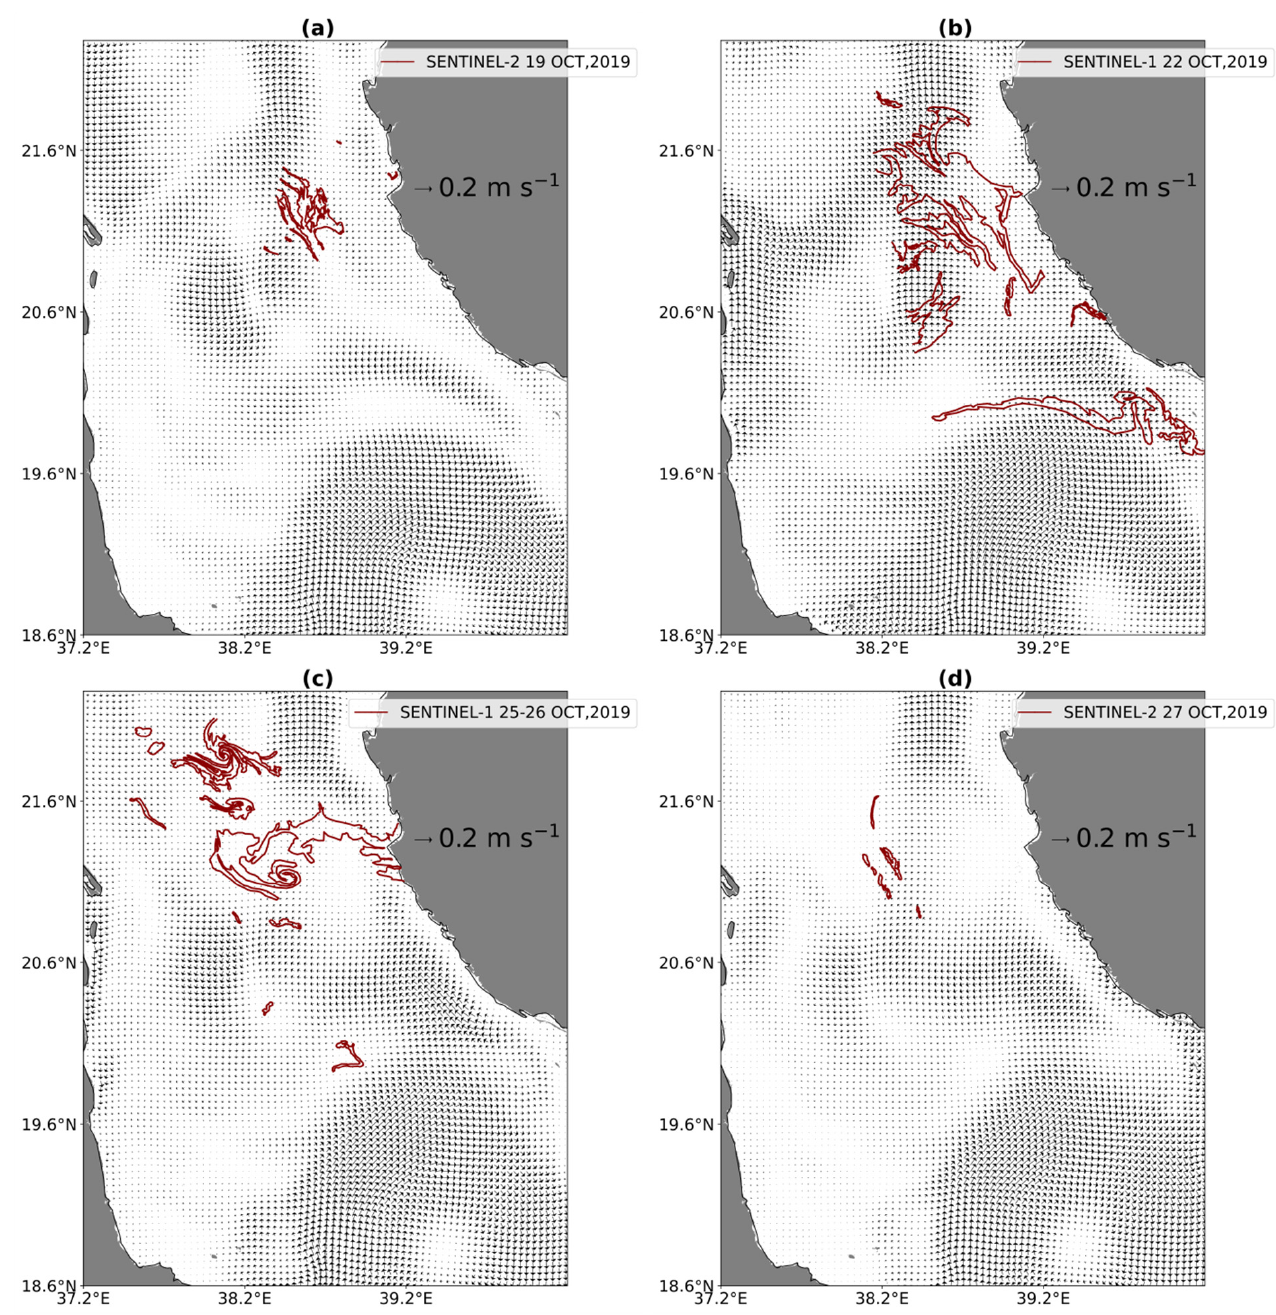
Figure 13. Same as Figure 12, but for ( a ) 19 October 2019 (nine days after the spill), ( b ) 22 October 2019 (twelve days after the spill), ( c ) 25 and 26 October 2019 (fifteen days after the spill), and ( d ) 27 October 2019 (seventeen days after the spill).